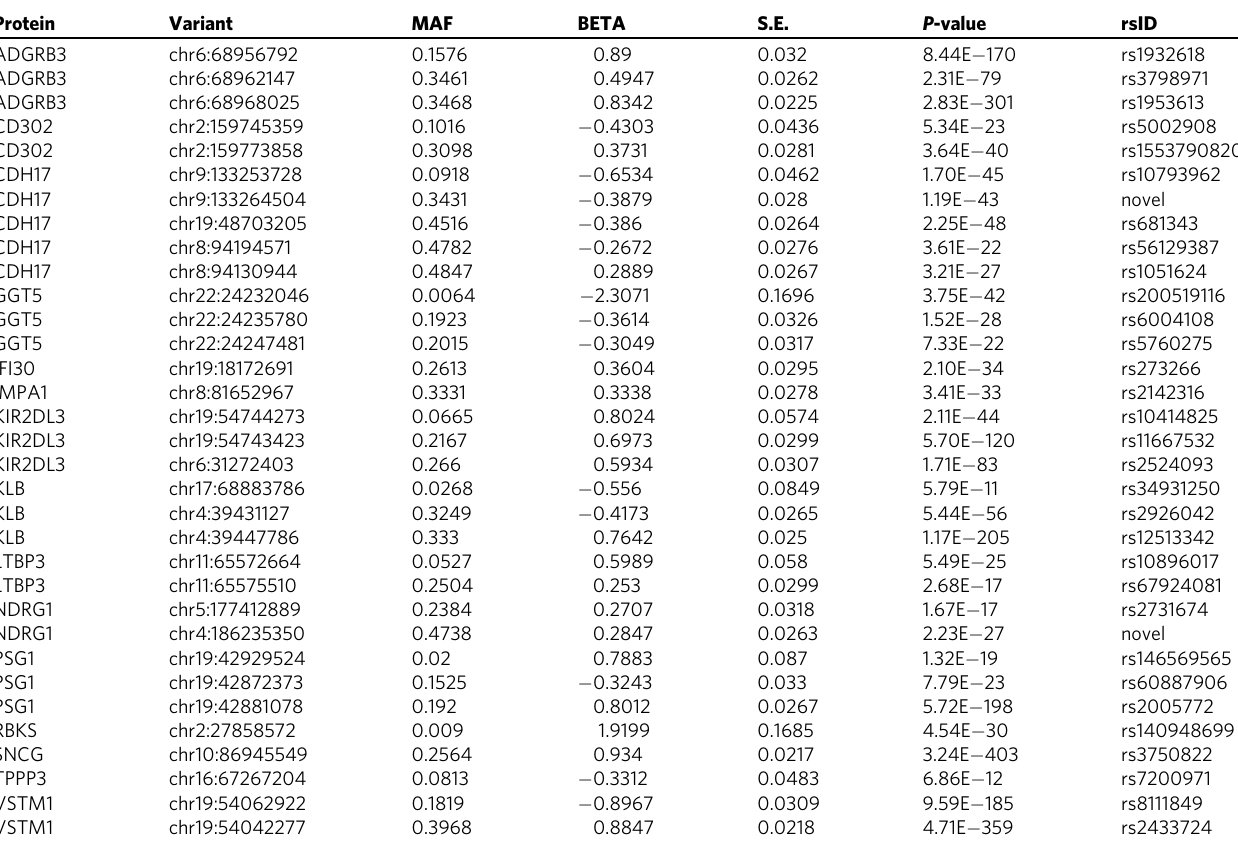
Table 1 Independent pQTL variants for proteins that are being analysed for the fi rst time. Protein Variant MAF BETA S.E.